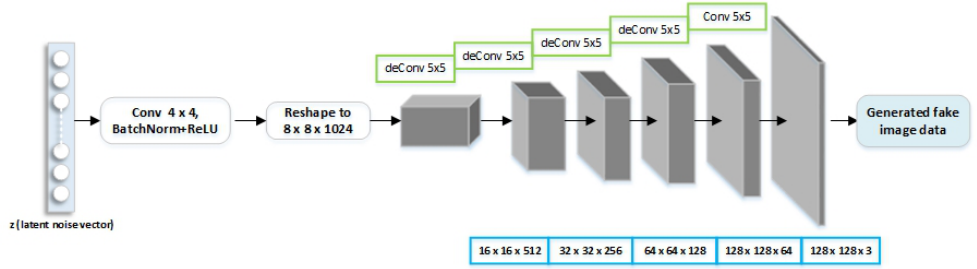
Figure 3. The architecture of the